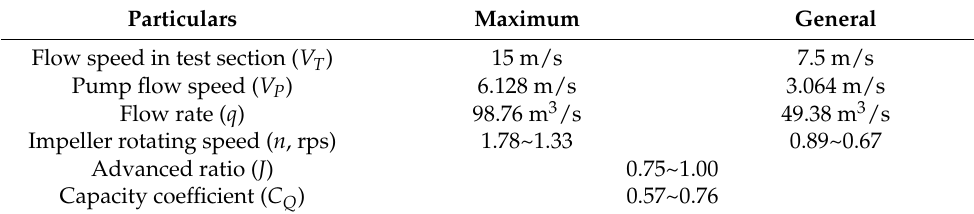
Table 3. Calculation